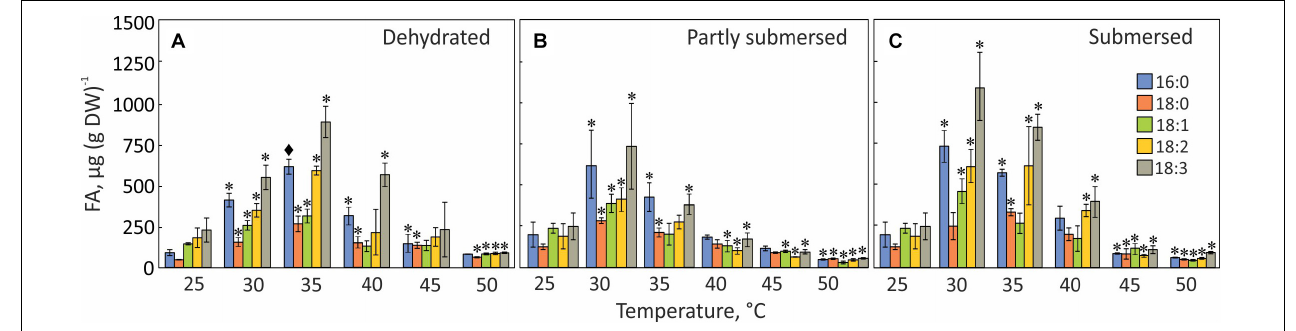
FIGURE 11 | FA profiles in dried (A) , partly submersed (B) , and fully submersed (C) fronds after exposure to various temperatures for 24 h. 16:0 = palmitic acid; 18:0 = stearic acid; 18:1 = oleic acid; 18:2 = linoleic acid; 18:3 = linolenic acid. Significance levels are based on the FA content of 25 ◦ C dry and hydrated fronds, respectively. Significant differences between treated and controls are indicated by * ( P ≤ 0.05) and (cid:7) ( P ≤ 0.001); means ± SE, n =